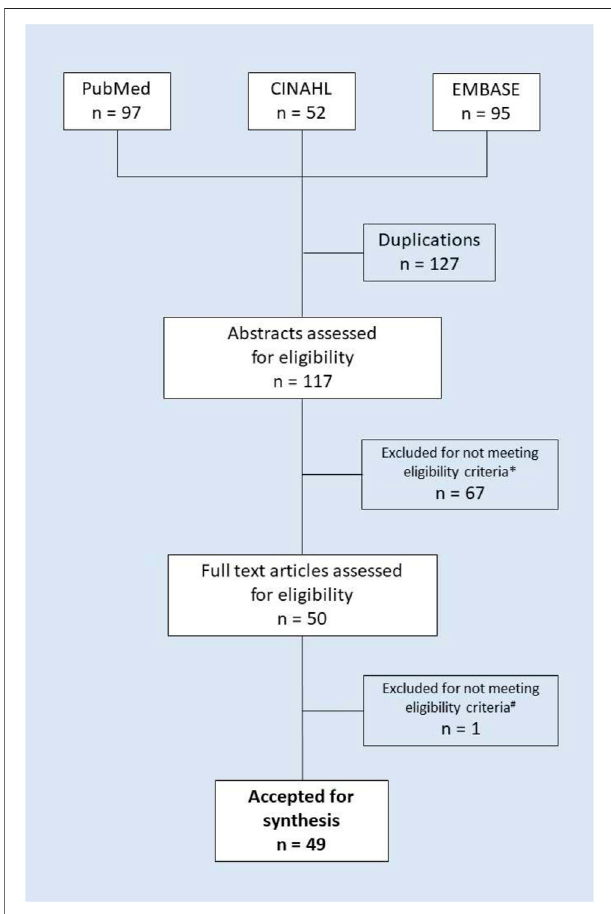
FIGURE 1 | PRISMA fl ow chart of the literature search and study selection. Note: * Excluded due to not detailing interventions to manage polypharmacy (56 items) or not meeting other eligibility criteria (e.g., not providing the details of the intervention, 11 items in total); # excluded for not meeting eligibility criteria (non-English-language